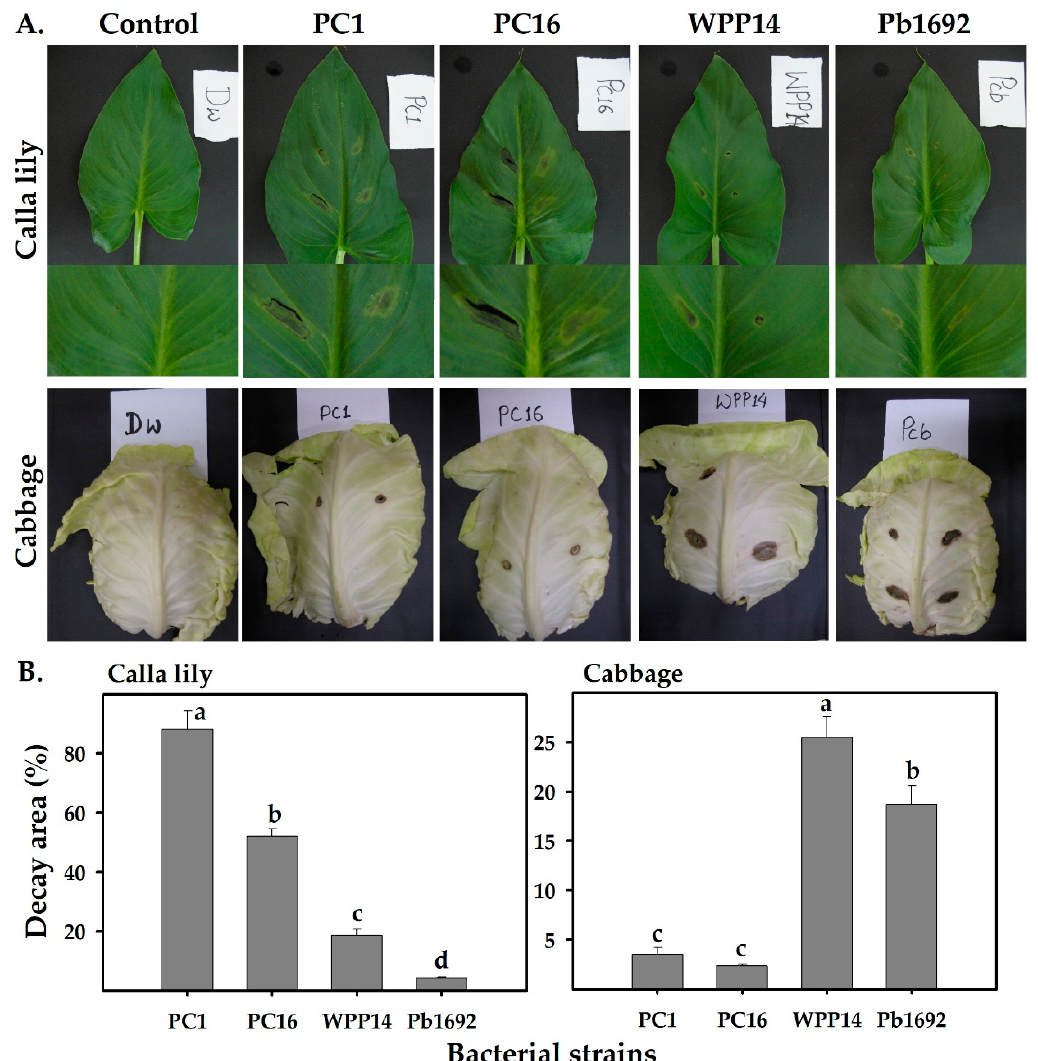
Figure 1. Disease symptoms on calla lily or cabbage leaves in response to inoculation with Pectobacterium strains isolated from monocot or dicot hosts. ( A ) Pectobacterium strains PC1 and PC16 ( P. aroidearum isolated from Ornithogalum dubium and Zantedeschia aethiopica , respectively), Pb1692 and WPP14 ( P. brasiliense and P. carotovorum , both isolated from potato) were infiltrated into calla lily or cabbage leaves (100 µL, 10 7 cfu/mL sterile DDW) and disease symptoms were evaluated 24 h after inoculation. ( B ) Leaf discs assessment of calla lily or cabbage inoculated with the same strains as above (10 µL of 10 8 cfu/mL). Infection was measured as percentage of decayed tissue at 15 h after inoculation. The full-leaf experiment (A) was repeated twice with five replicates and the leaf-disc experiment (B) was repeated twice with 20 replicates for each strain/host combination. Bars represents mean ± standard errors (SE) of decayed area (%). Bars not labeled with the same letter (a–d) are significantly different from each other (one-way ANOVA with post hoc Tukey HSD test, p < 0.05).